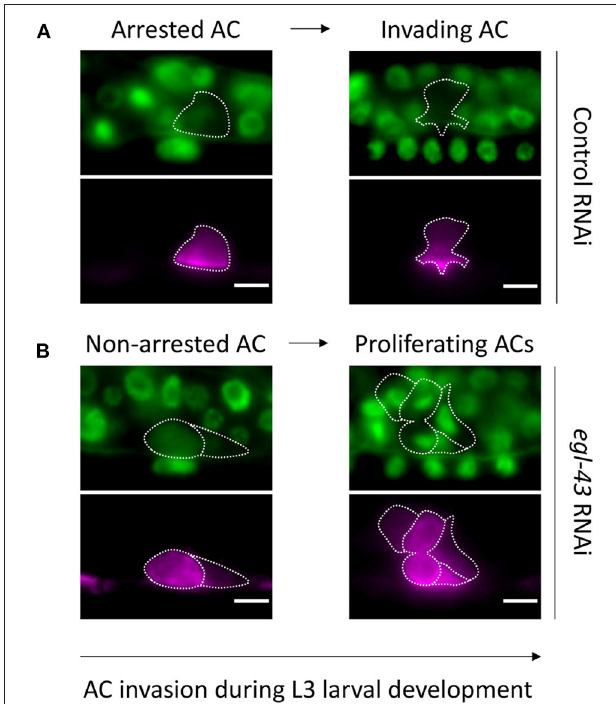
FIGURE 1 | Observing AC invasion in C. elegans larvae: (A) Animals treated with control RNAi showing a non-dividing AC associated with normal invasion at the 1-cell (A ′ ) and 4-cell (A ′′ ) stage. (B) The AC in egl-43 RNAi treated animals continues to divide and is incapable of invading between the primary VPCs. Note that the left AC (B ′ ) is in early anaphase and the middle AC (B ′′ ) is about to complete its division. (A,B) Upper rows depict cell nuclei with GFP::MCM-7 and the basement membrane with LAM-1::GFP. Lower rows illustrate corresponding AC as labeled with a cdh-3 > mCherry::PH maker. The arrow depicts developmental